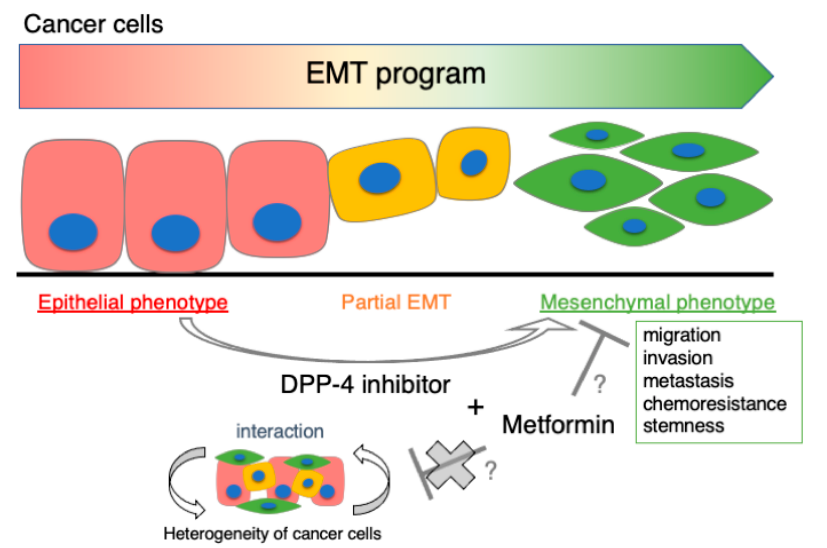
Figure 2. DPP-4 inhibitor-induced cancer progression is attenuated by metformin. Cancer cells exist in various phases of the EMT process; epithelial-like, mesenchymal-like, or partial phenotype of cancer cells. These heterogeneous cancer cell populations interact with each other and effectively develop in cancer biology. The DPP-4 inhibitor progresses cancer cells to a more mesenchymal phenotype, which is associated with tumor progressions such as migration, invasion, metastasis, chemoresistance and stemness. Metformin is likely to have an anti-tumor effect on homogenous mesenchymal cancer cell population induced by DPP-4 inhibitor. DPP-4: dipeptidyl peptidase-4; EMT: endothelial-mesenchymal